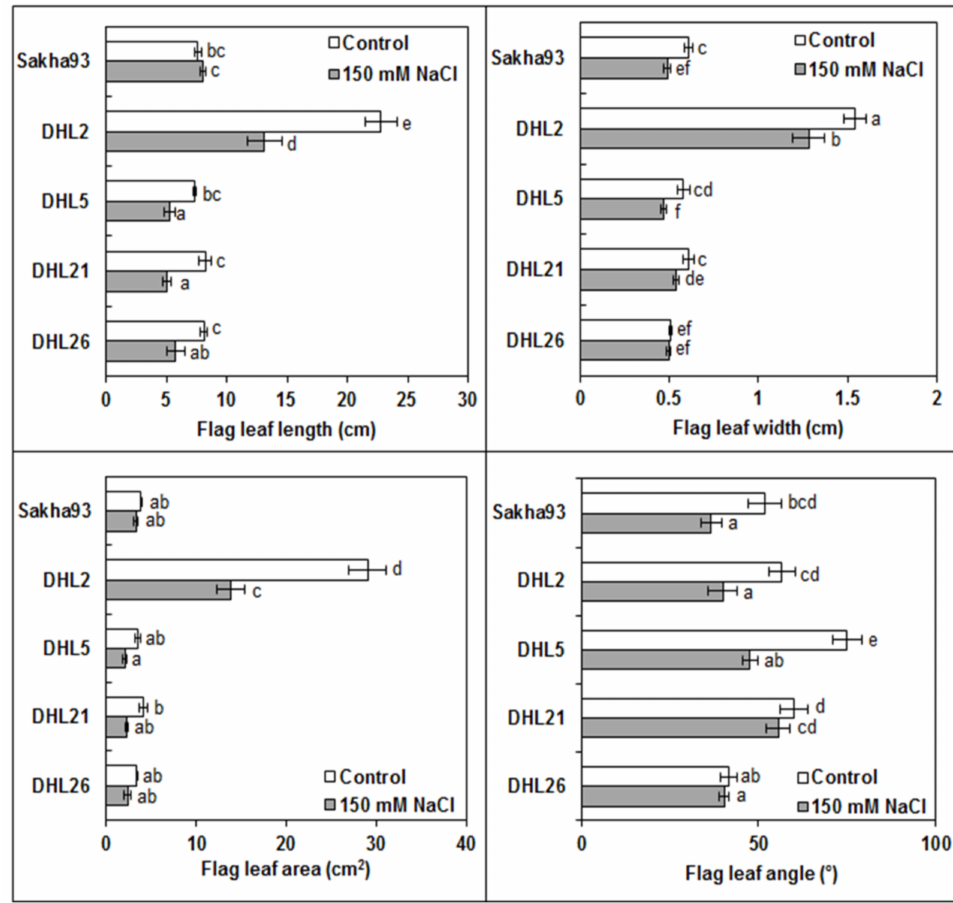
Figure 6. Impact of salinity on flag leaf characteristics in five wheat genotypes subjected to irrigation water with or without 150 mM NaCl. Values are presented as the mean ± SE of at least three replications, and values sharing the same letter for each treatment × genotype combination are not significantly different ( p ≤ 0.05) according to Duncan’s multiple range